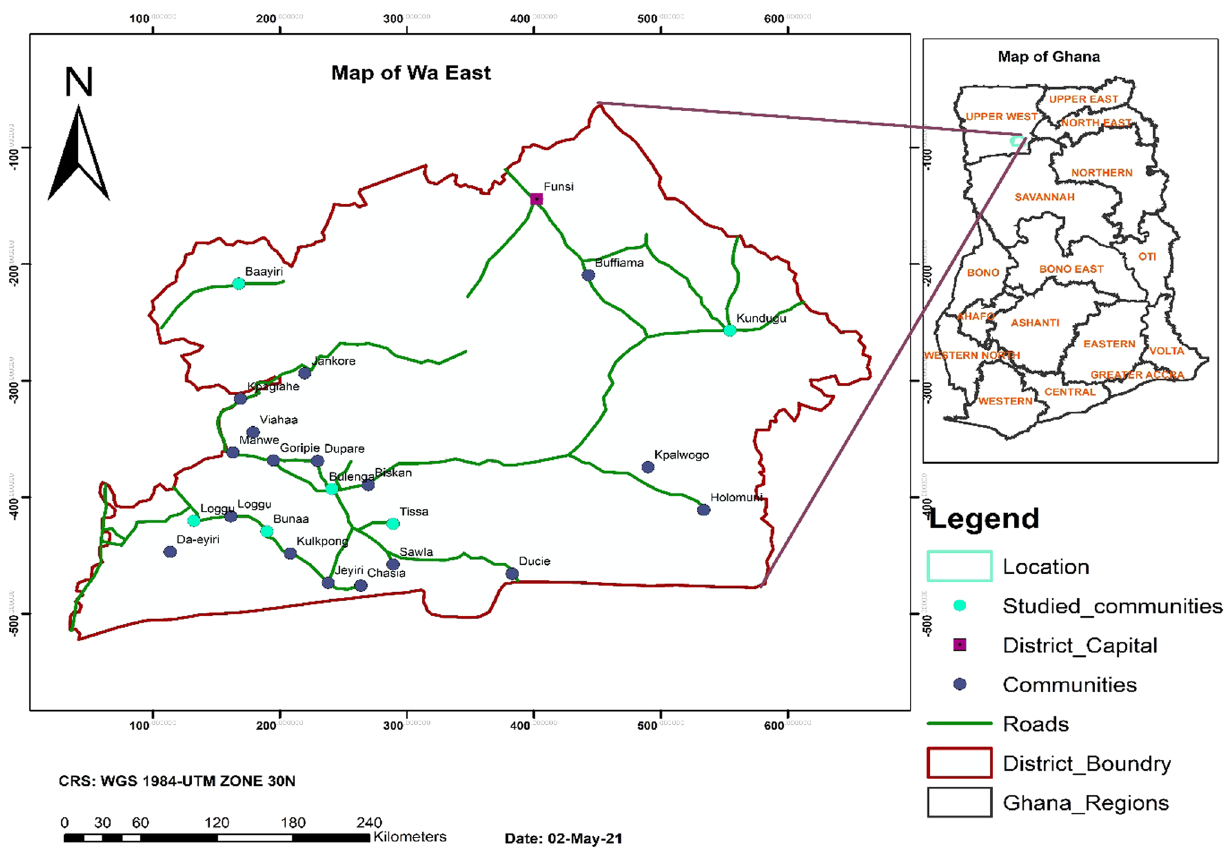
Fig. 1 Map of study areas. Source: Digitized and modified from GSS, 2014